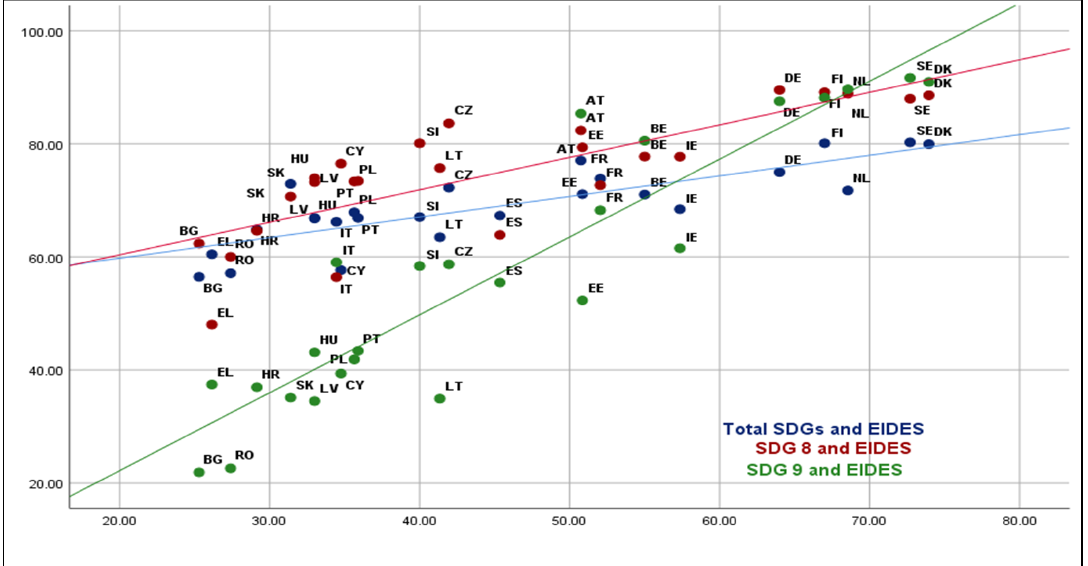
Figure 3. Positive link between digital entrepreneurship (EIDES) and sustainable development goals (Total SDGs, SDG 8 and SDG 9). Source: own calculations based on [26,92,93]. Table 3. Regression results: the impact of digital entrepreneurship (EIDES) on the achievement of SDGs (Total SDGs, SDG 8 and SDG 9).